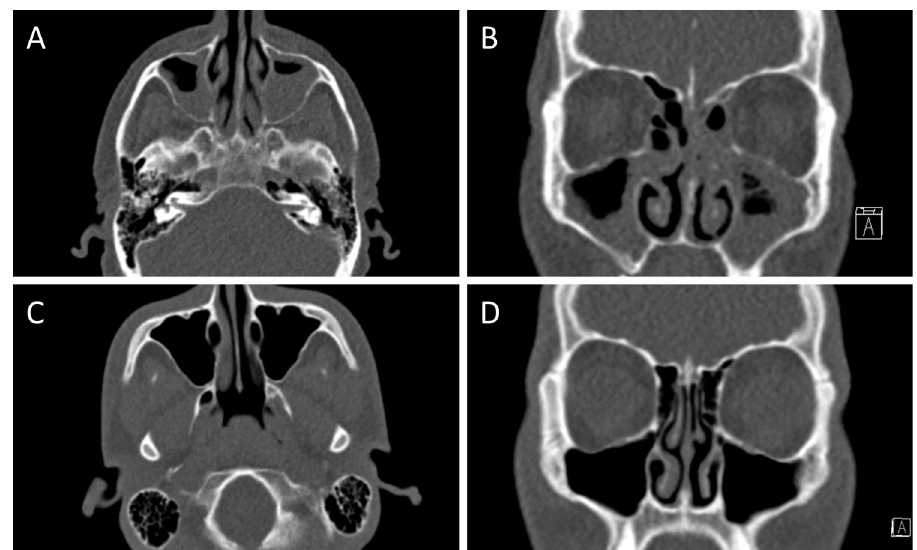
Fig 1. Ultra-low-dose CT-images of paranasal sinus. Axial (A) and coronal (B) reformations of 100 kV tin-filtered ultra-low-dose CT of the paranasal sinus of a 63-year-old male (DLP 2.1 mGycm; effective dose 0.012 mSv). Despite the very low dose, the diagnosis of florid sinusitis is easily established. In a 19-year-old male (axial C, coronal D), sinusitis was sufficiently excluded (DLP 1.8 mGycm; effective dose 0.010 mSv). The general image quality in both patients was rated as “moderate” by both readers.